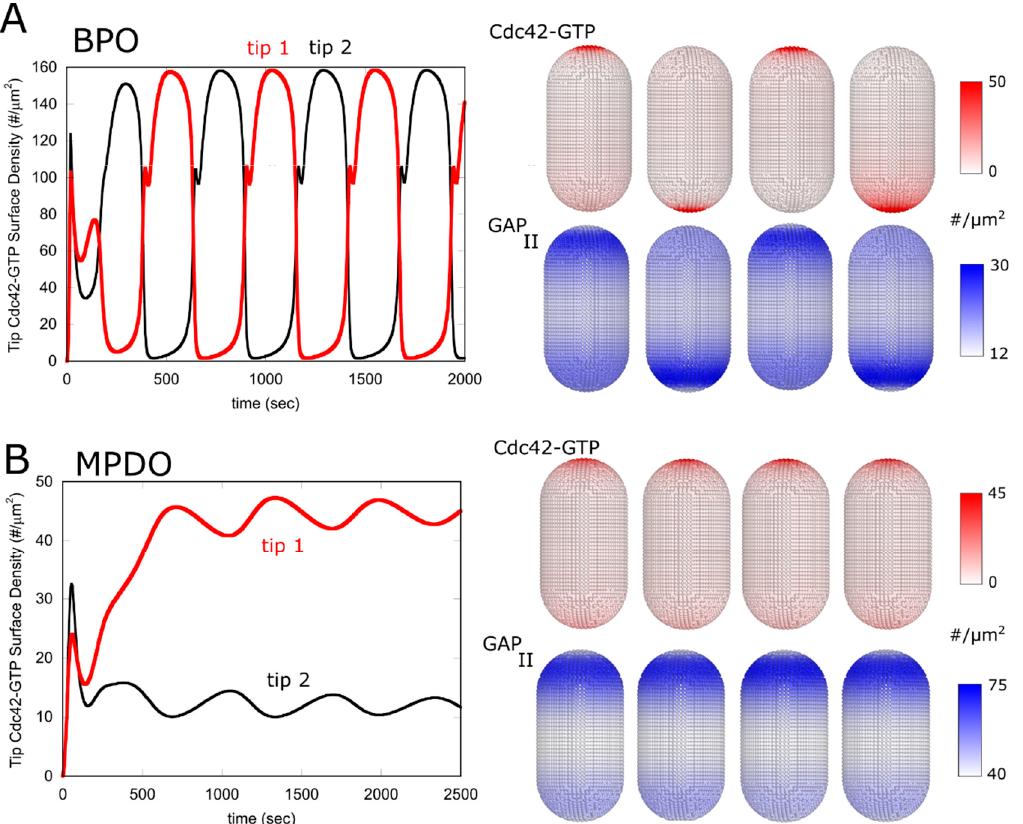
Figure 3. Examples of symmetric oscillations (bipolar oscillatory, BPO) and asymmetric damped oscillations (monopolar with damped oscillations, MPDO) solutions. ( A ) Graph shows concentration of Cdc42-GTP at each tip, as a function of time starting from an unpolarized state with both tips inactive. The concentration profiles of the other components in the system that are not shown follow the same trends as in the stationary states of Figure 2. Snapshots show Cdc42-GTP and total GAP II profiles every 200 s once the system evolved to a periodic pattern. Parameter values same as shown in Table 1 except 𝑘 (cid:2873)(cid:3041) = 0.01 /s and 𝐸 (cid:2887)(cid:2930)(cid:2925)(cid:2930) = 500. ( B ) Same as panel A, but for an MPDO case where the system eventually evolves to a stationary asymmetric state through damped, anticorrelated oscillations. Snapshots show Cdc42-GTP and total GAP II profiles every 200 s, starting at 1000 s. Parameter values same as shown in Table 1, except 𝐸 (cid:2887)(cid:2930)(cid:2925)(cid:2930) = 210 .